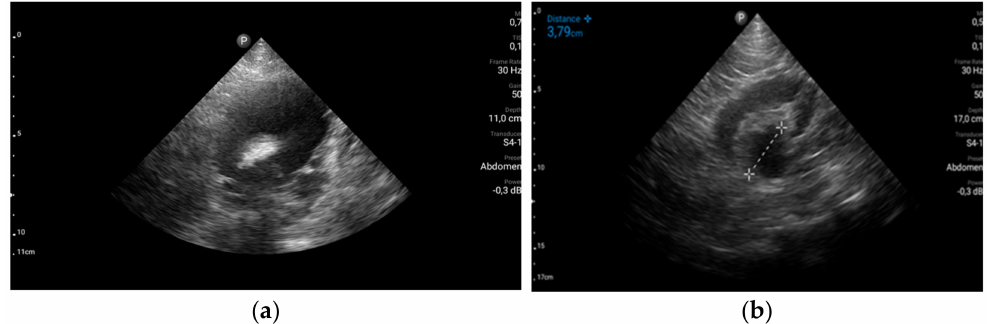
Figure 2. Abdominal ultrasound. ( a ) Hypogastric transversal section: urinary bladder obstructive stone, 3 cm in diameter and distended urinary bladder; ( b ) Right flank longitudinal section: third degree hydronephrosis of the right kidney.